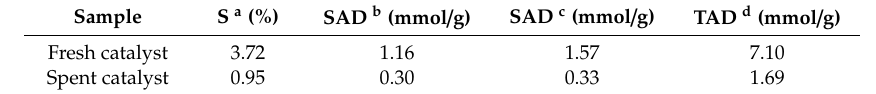
Figure 14. Reusability of the OMSC catalyst in glycerol conversion (GC) and selectivity to monoacetin (MA), diacetin (DA) and triacetin (TA) in five reaction cycles (C1 to C5). Table 4. Sulfur content and acid properties of the fresh and the spent catalyst after the fifth